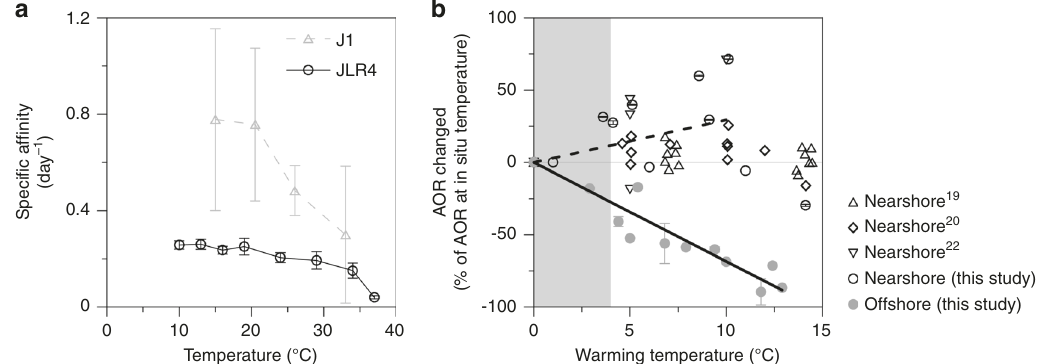
Fig. 5 Thermal response projections in near- and offshore regions. a The thermal responses of speci fi c af fi nity at the J1 and JLR4 stations. Data are expressed as the mean values ± SD ( n = 10 in J1 station; n = 48 in JLR4 station; independent experiments). b Normalized warming-driven variations in ammonia oxidation rates. Rate changed (%) is relative to the ammonia oxidation rate (AOR) at in situ temperature. The mean increase (nearshore hollow dots) is denoted by the dashed line and the mean reduction (offshore, solid dots) is denoted by the solid black line. The shaded area represents the 4 °C increase in temperature mentioned in the IPCC study. Note that the stations where the surface salinities are lower than 32 are classi fi ed as nearshore station, and the others are classi fi ed as offshore stations. The data in ( b ) are presented as mean values, instead of standard deviation the given bars indicate the variation range of two independent